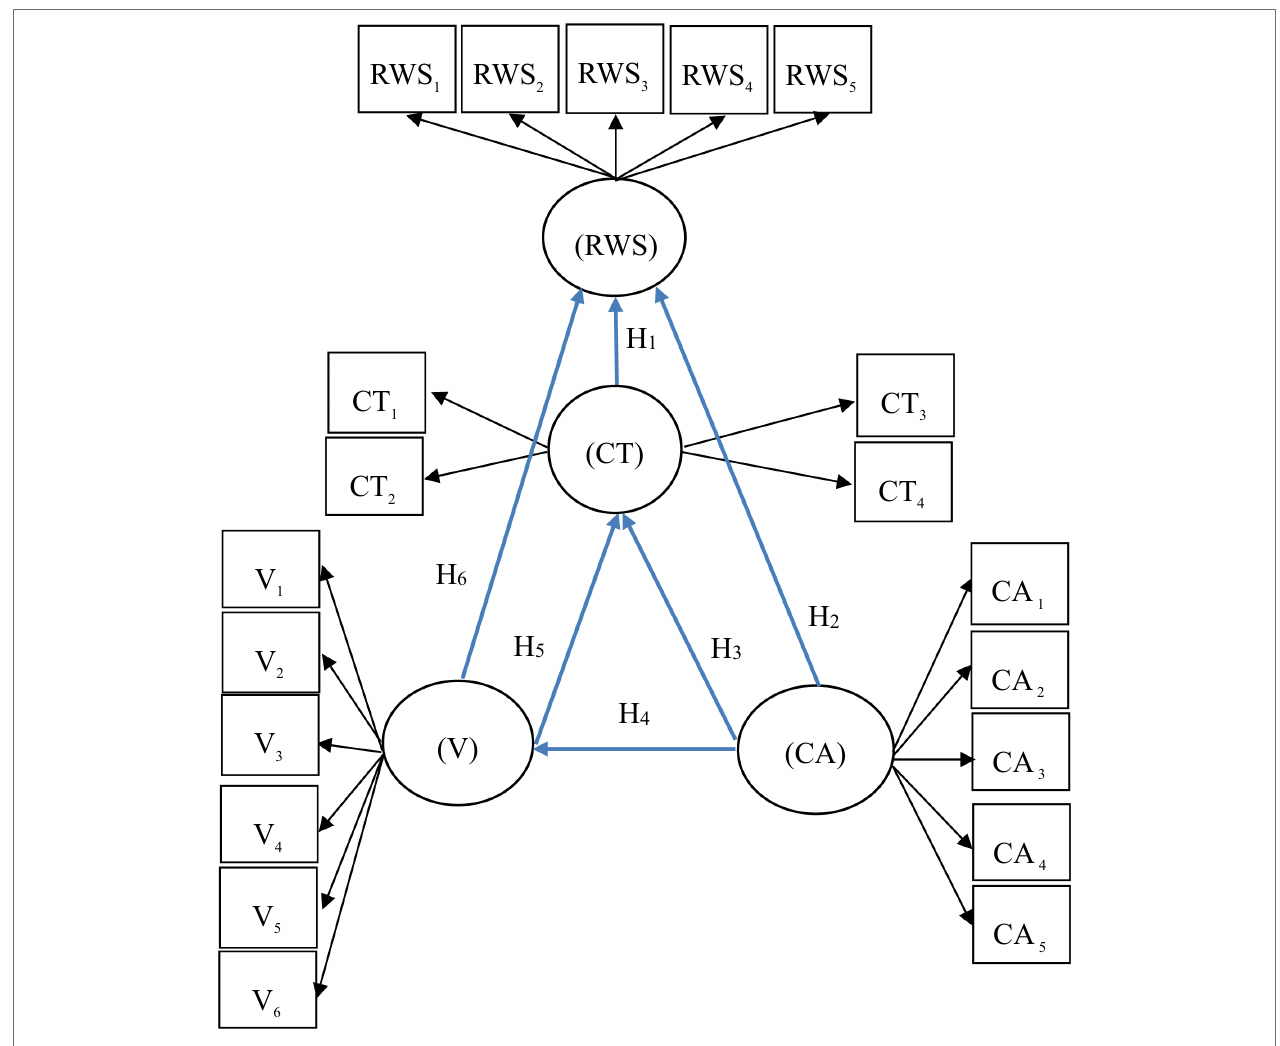
FIGURE 1 | Presentation of the